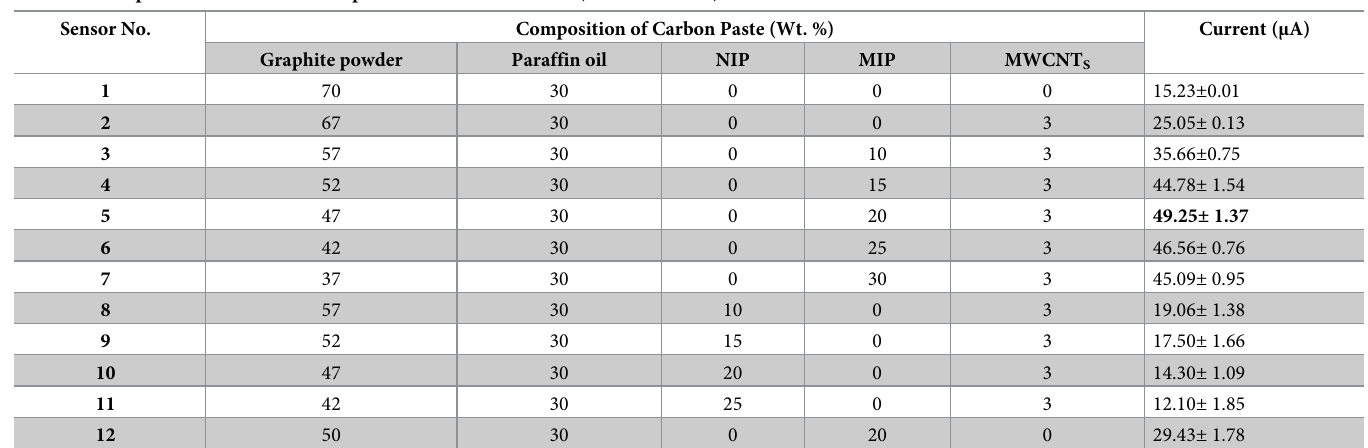
Table 1. The optimization of sensor composition to determine CBZ (1 × 10 − 7 molL − 1 ). Sensor No. Composition of Carbon Paste (Wt.